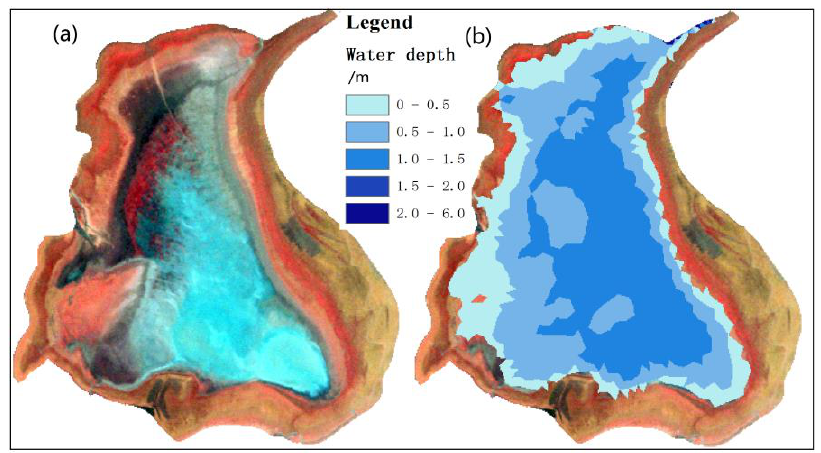
Figure 10. Comparison of actual and simulated water levels in a dish-shaped lake (Bang Lake). ( a ) represents the actual water surface, ( b ) represents the simulated water surface. The legend represents the depth of ( b ), and the water in ( a ) is blue.